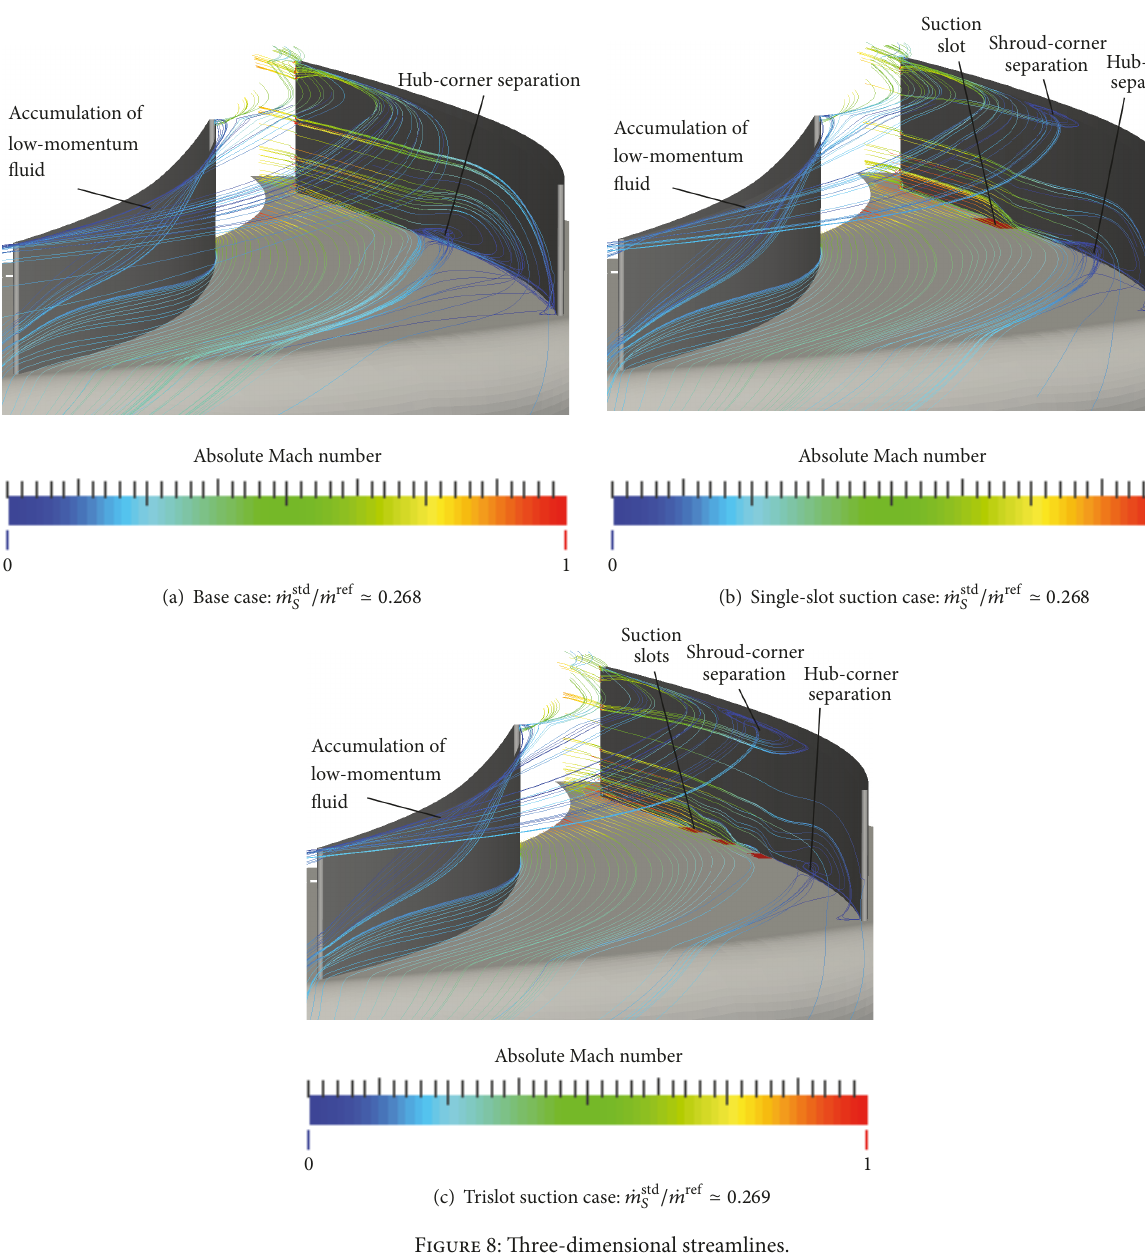
Figure 7: Maximum of instantaneous adverse pressure gradient—three-slot suction case.